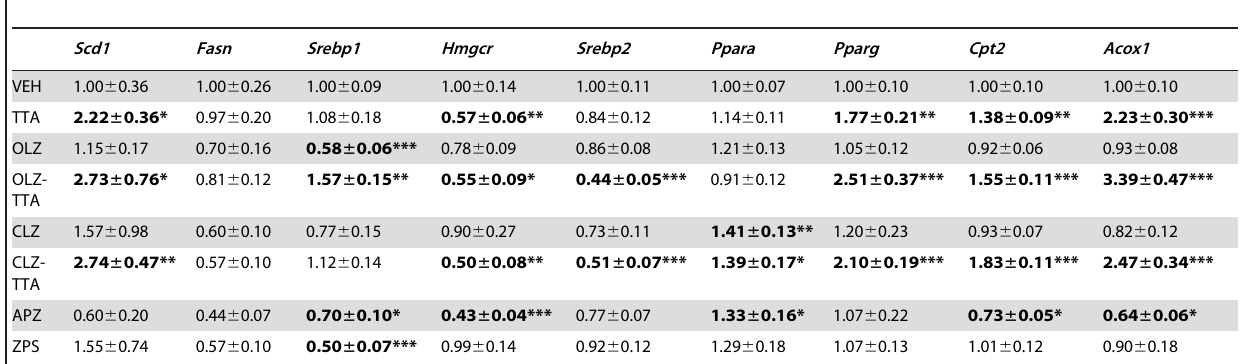
Table 5. Selected genes with drug exposure-related, differential expression in liver in the chronic